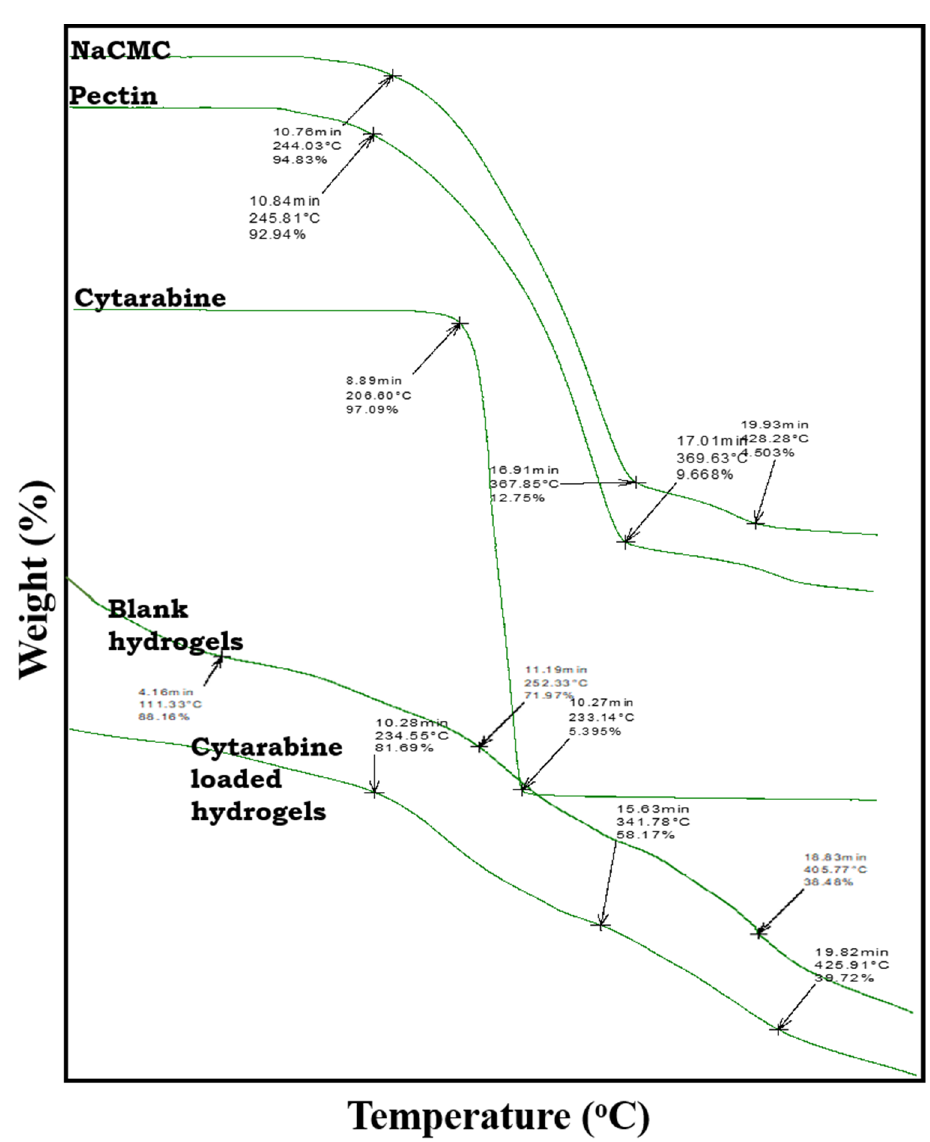
Figure 4. TGA thermograms of Na-CMC, pectin, cytarabine, blank hydrogel, and cytarabine- loaded hydrogel.